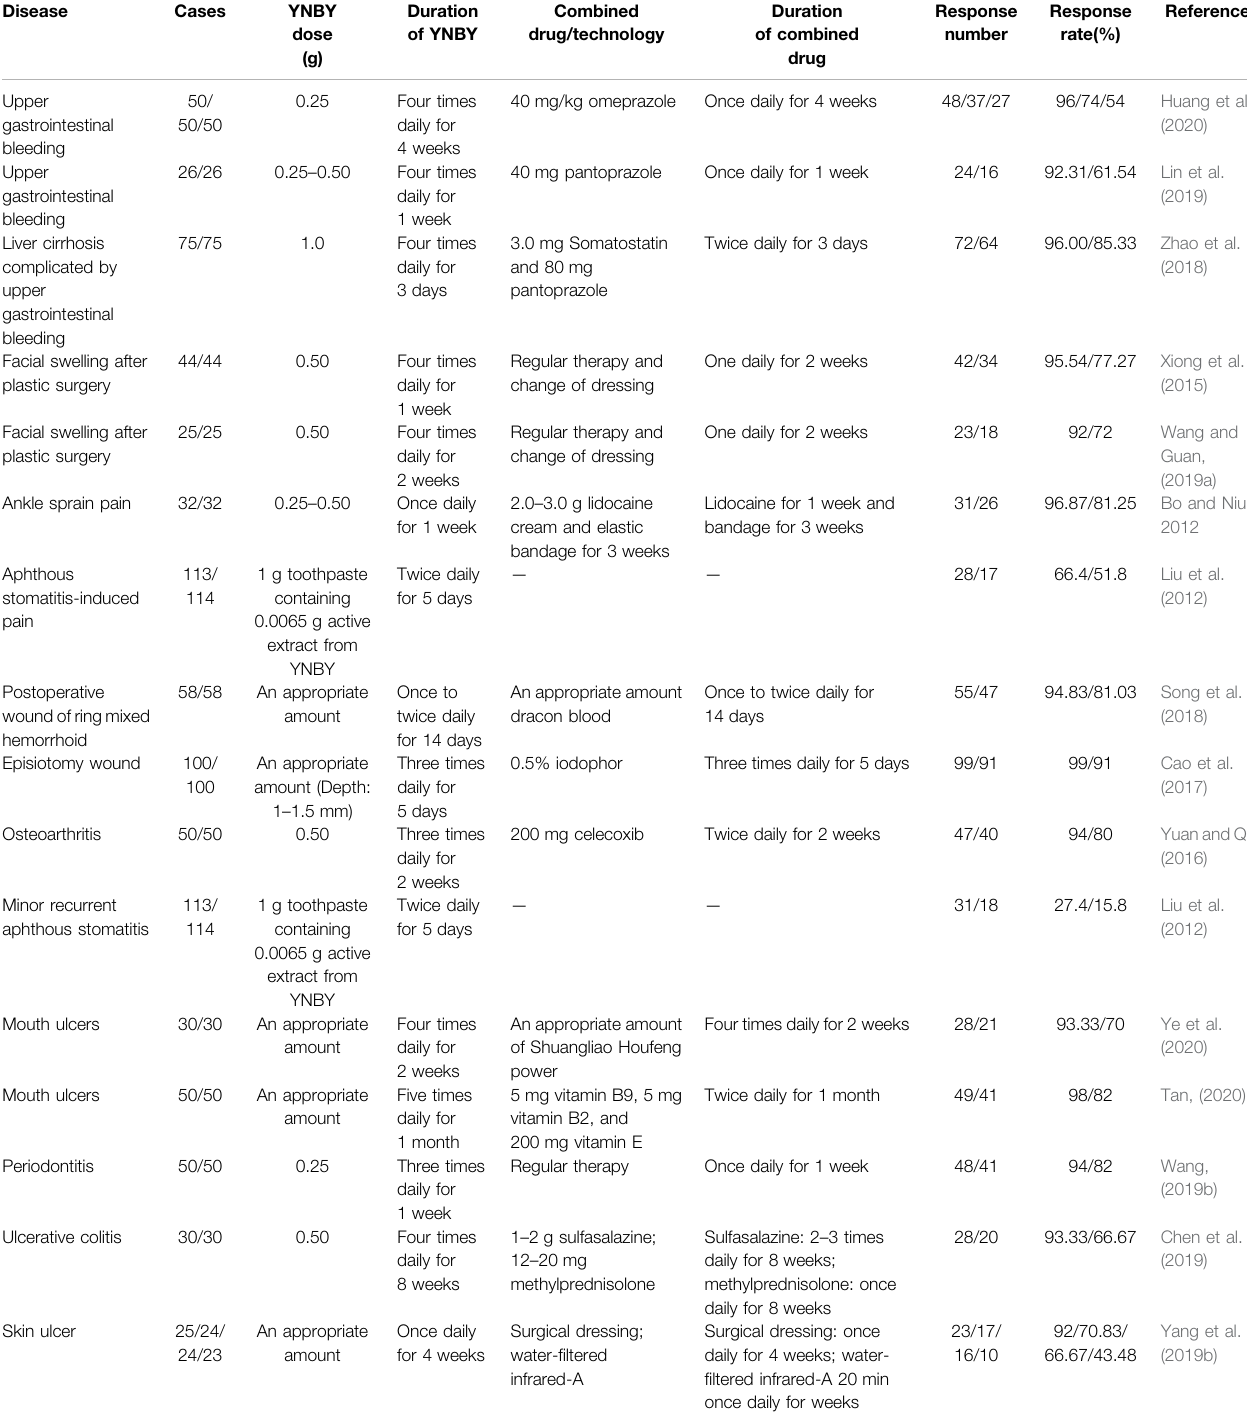
TABLE 5 | The clinical applications of